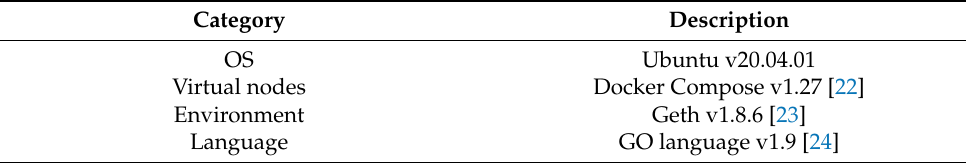
Table 3. Testnet